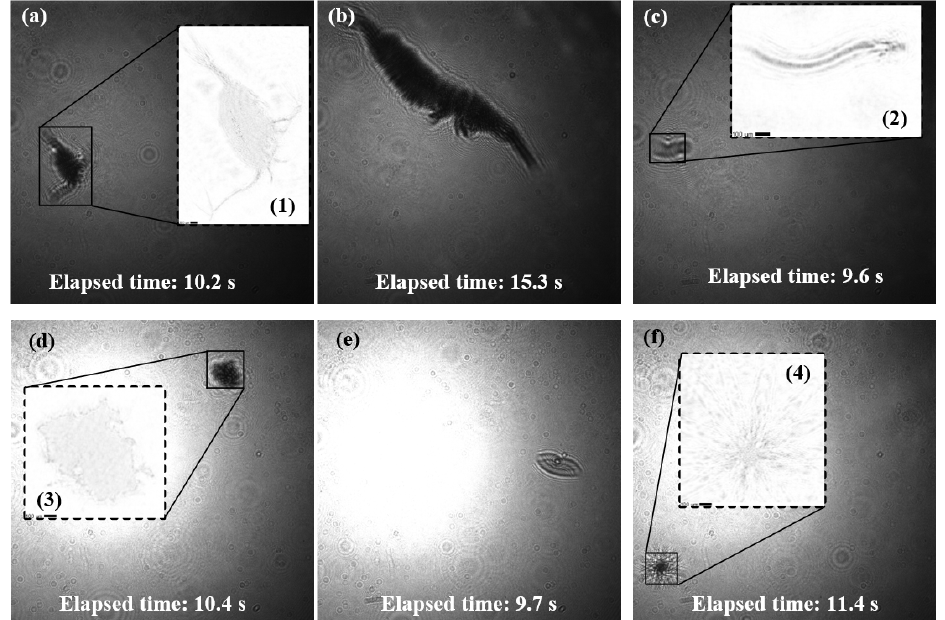
Figure 16. Montages obtained by processing the holograms of Figure 4a–f using the data processing software Holo-Batch, accompanied by the LISS-Holo system. ( a – f ) with processing times respectively of 10.2 s, 15.3 s, 9.6 s, 10.4 s, 9.7 s, 11.4 s. (1–4) are extracted plankton images. If there is no local magnification in the figure, the plankton image was not successfully obtained.